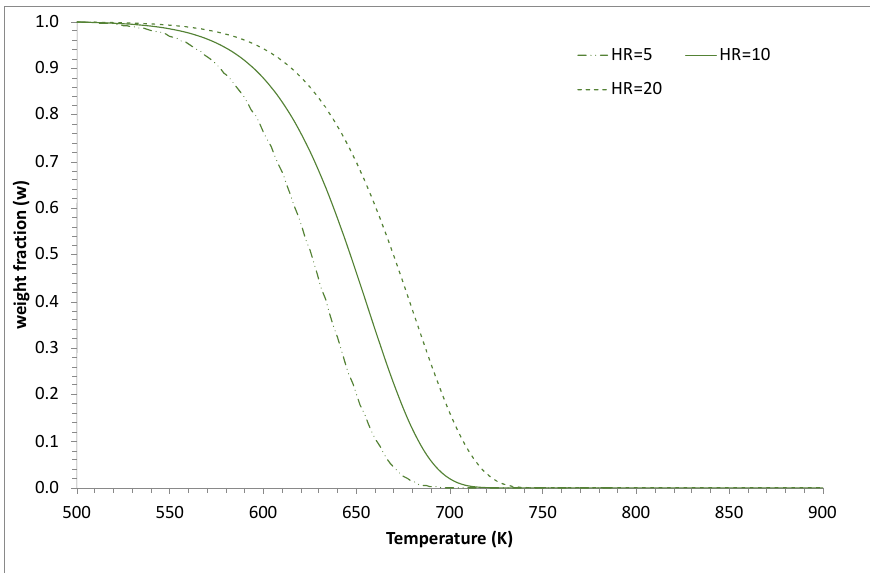
Figure 3. Effect of the heating rate (HR) on the decomposition curve’s position without varying the kinetic constants. In this case, the curve moves appreciably to the right when the HR increases (in K/min, indicated in the graphics).